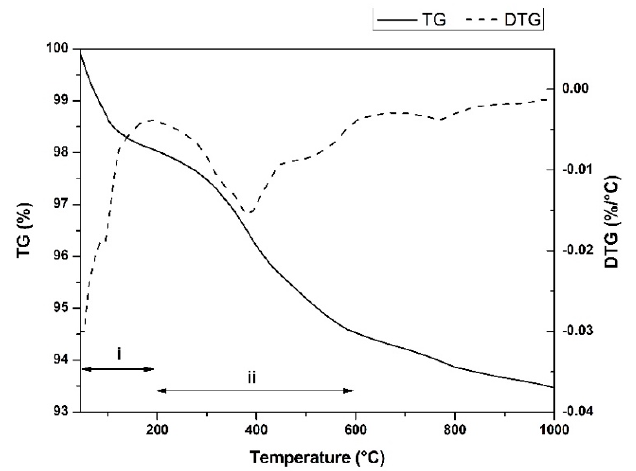
Figure 3. TGA curve of the PPR.